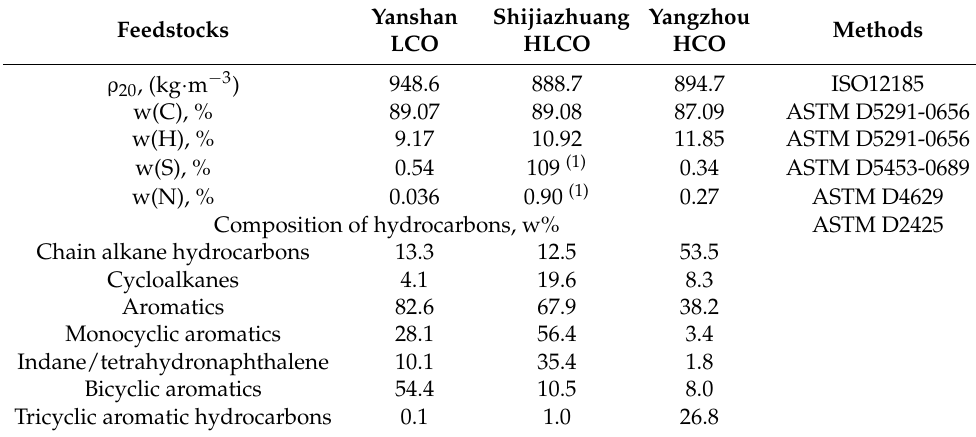
Table 1. Properties of the experimental feedstocks.